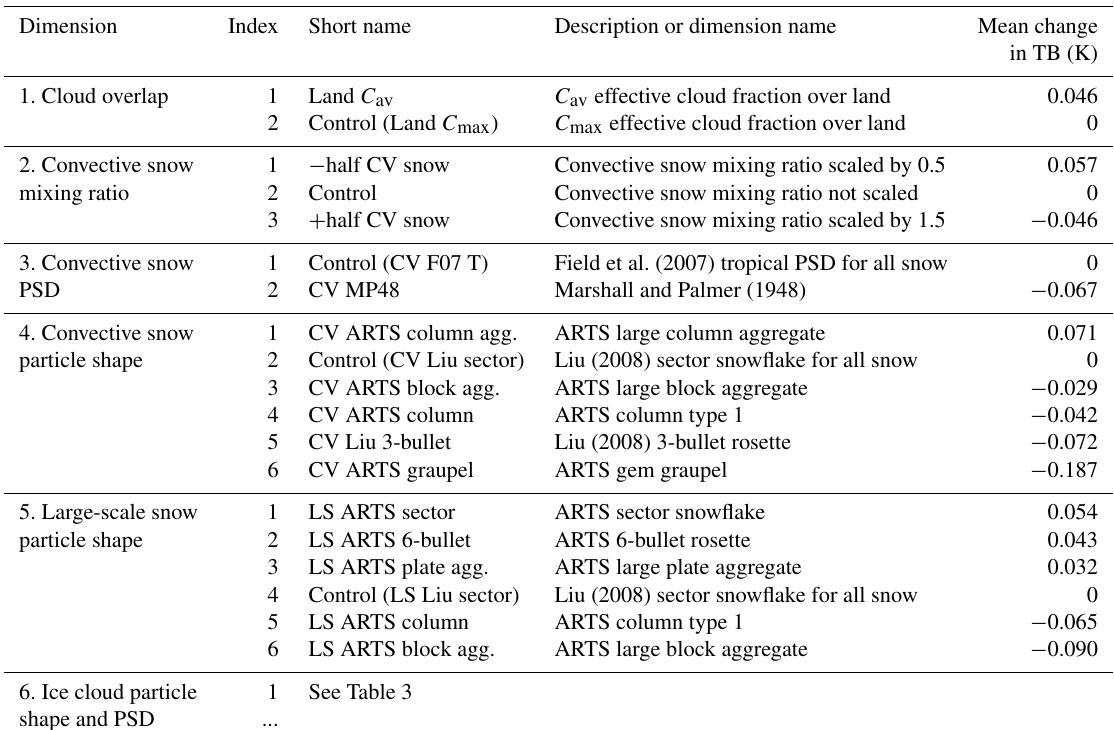
Table 2. Possible microphysical and macrophysical changes. For details, see text.